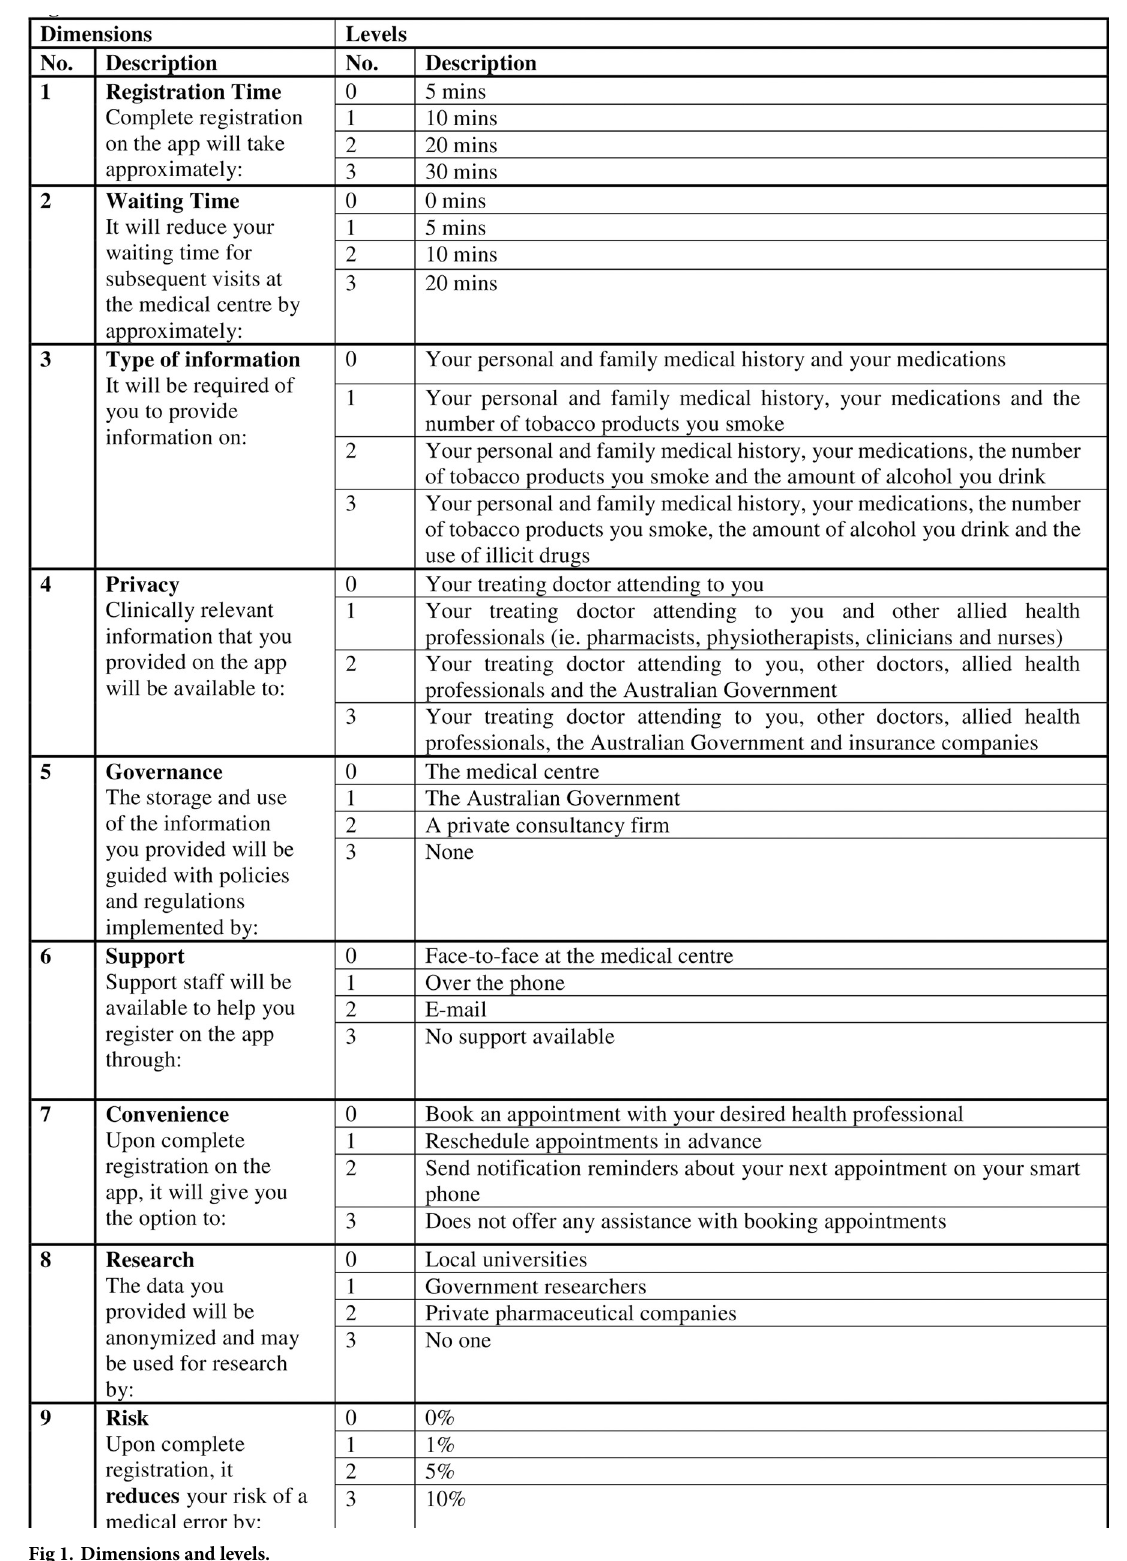
PLOS ONE | https://doi.org/10.1371/journal.pone.0229546 February 21,